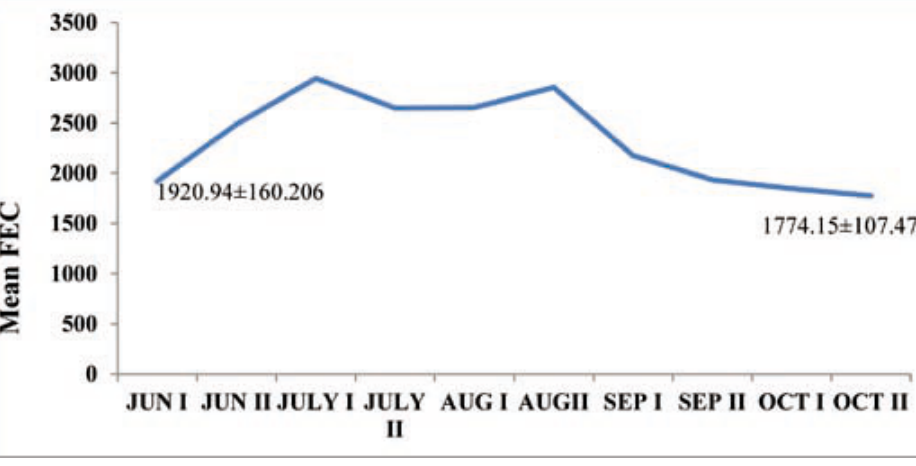
Fig.2. Intensity of strongylosis (FEC) during the study period throughout the study period (Fig.2). The highest FEC (mean ± S.E) of 2945.87±188.530